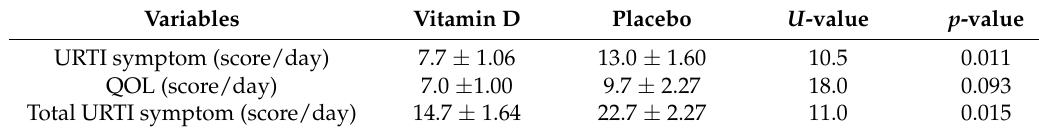
Table 2. The symptoms of URTI during winter training.